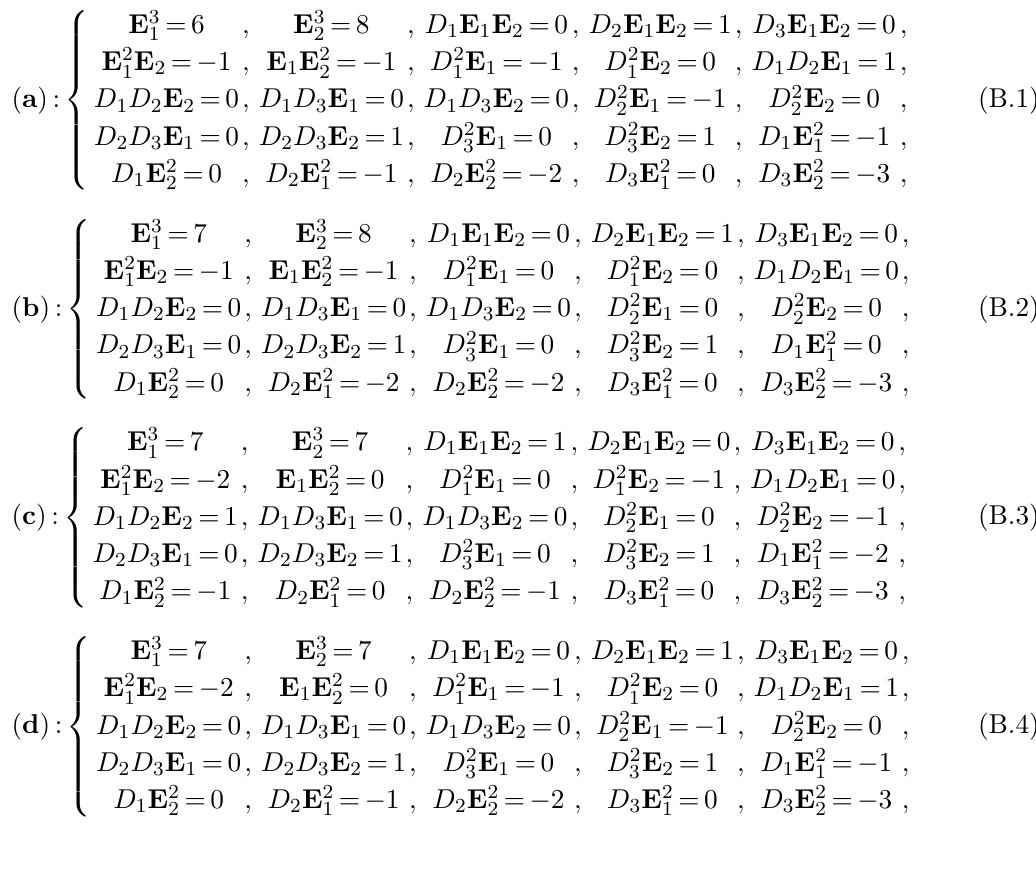
Table 7 . Instanton masses in the 16 chambers of the SU(3) k Resolutions that have a vertical